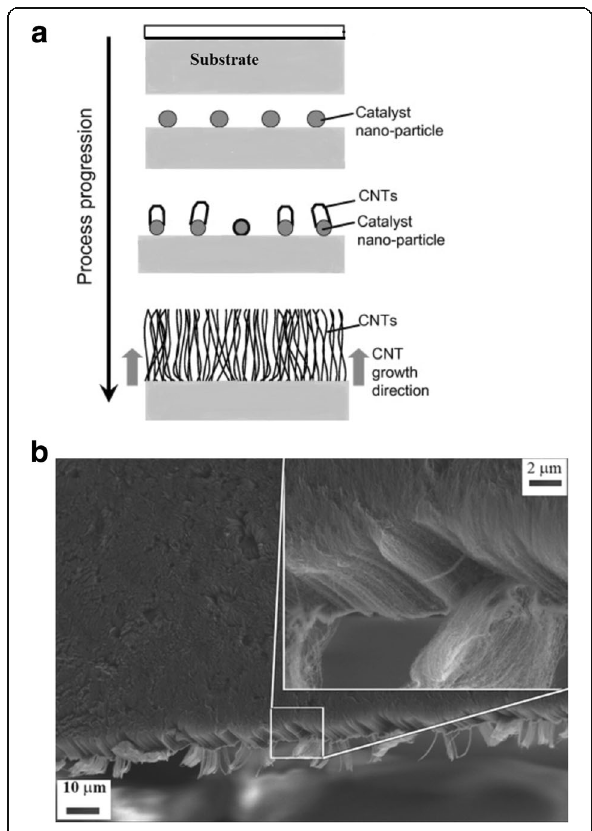
Fig. 30 a Critical stages of CNT forest growth from a pre-deposited catalytic thin film using the multi-step plasma-induced CVD technique: formation of high-density plasma-induced nanoparticles, nucleation, and CNT forest formation. Adapted from [221]. b SEM image of the closely-packed MWCNT forest grown using plasma- induced CVD. Adapted from